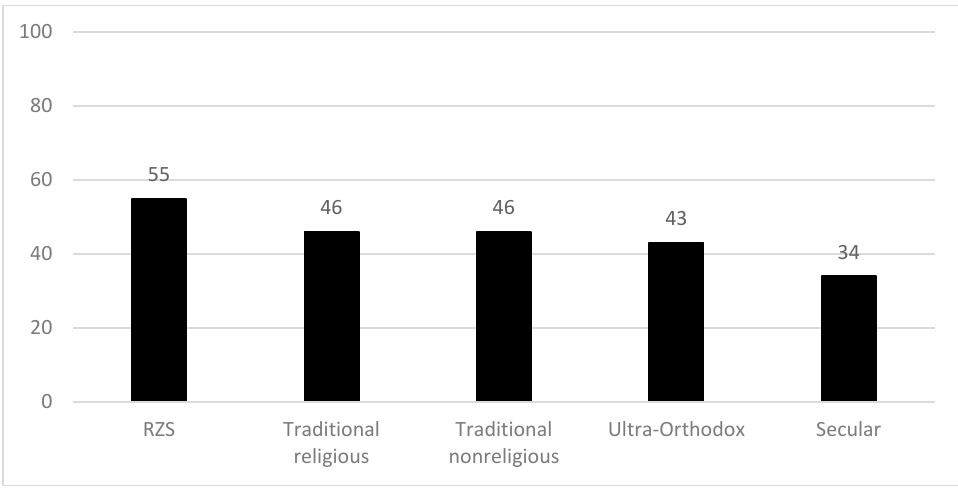
Figure 6. Optimistic about the future of Israeli democracy, by level of religiosity (%) (Source: Israeli Voice Index, July 2020 ‒ July 2021).